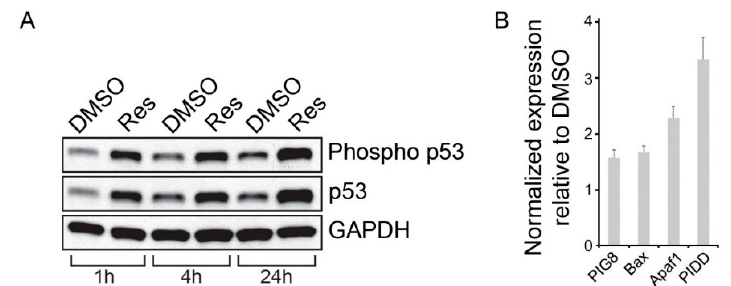
Figure 7. ( A ) Resveratrol increases the expression and phosphorylation of p53 in choroidal endothelial cells. Cells were exposed to 100 µM resveratrol, after which proteins were resolved by SDS-polyacrylamide gel electrophoresis and western blots were stained with specific antibodies. GAPDH served as a control for equal protein loading of the gel. ( B ) RNA from cells treated with 100 µM resveratrol for 6 h was used for qPCR with primers for p53-dependent genes and PolR2a-primers as an internal